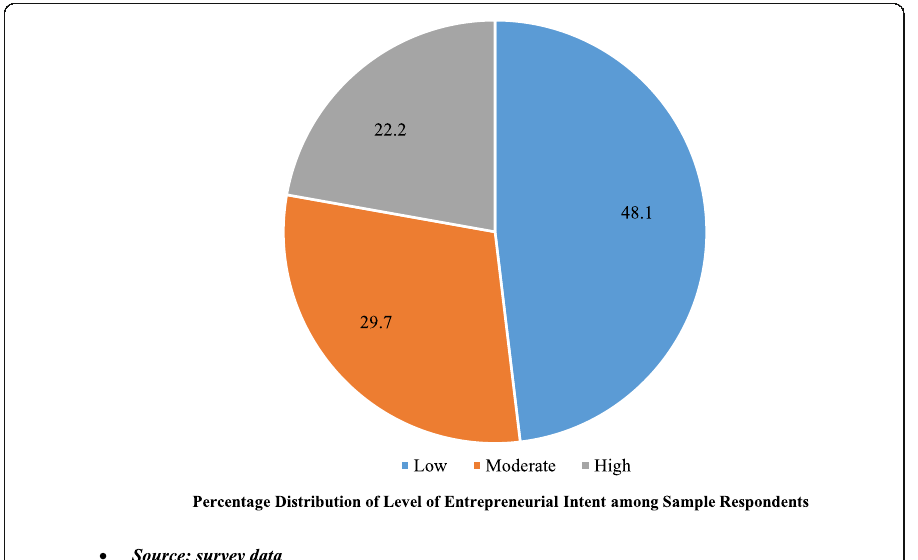
Fig. 1 Percentage distribution of level of entrepreneurial intent among sample respondents. Source: survey